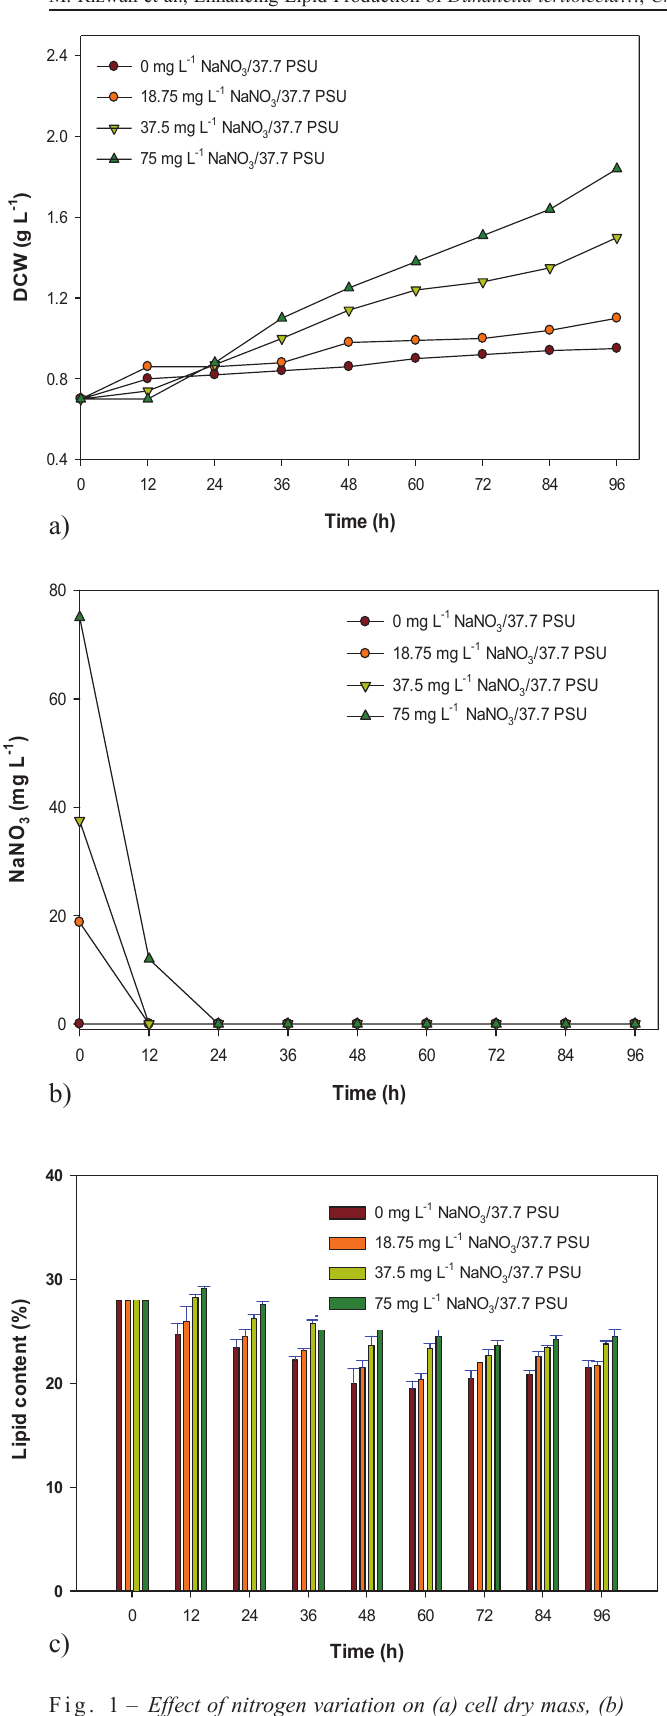
Fig. 1 – Effect of nitrogen variation on (a) cell dry mass, (b) nitrogen consumption, and (c) lipid content under normal salinity (37.7